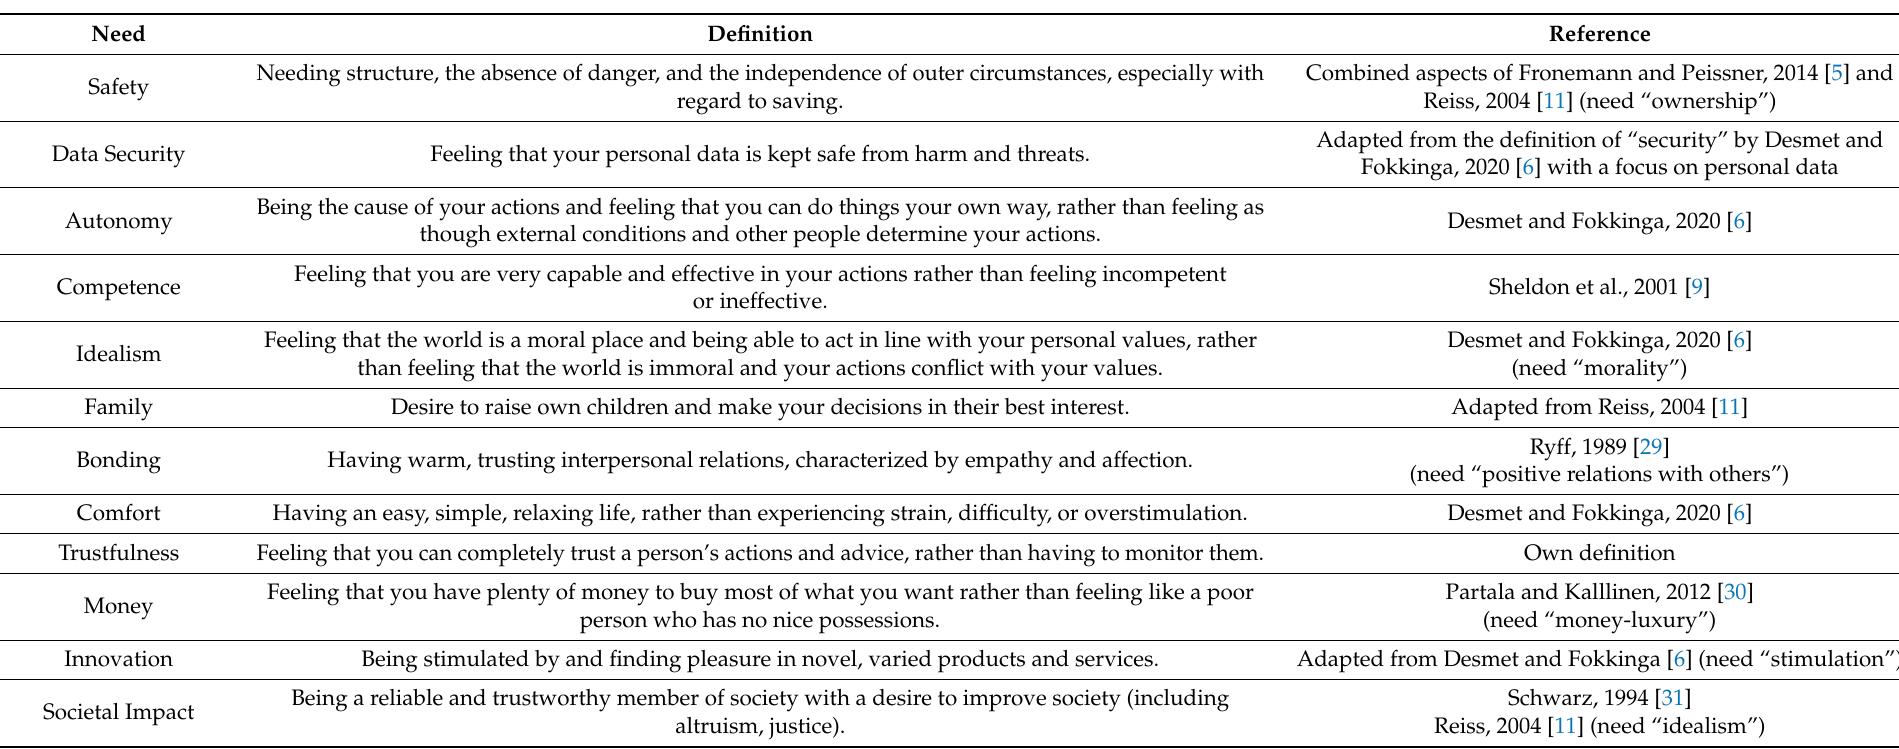
Table 1. Overview of the 12 needs identified as important in the banking context, their definition and, reference to related need